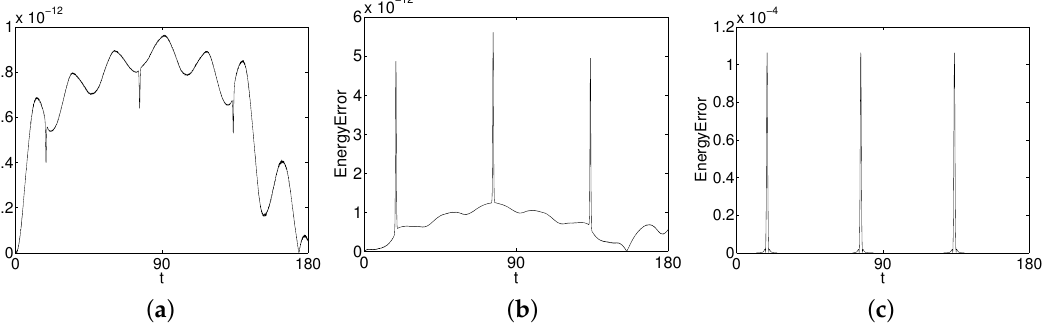
Figure 4. The kink and anti-kink solitary waves energy error of second order AVF method, fourth order composition method and second order Preissman method in t ∈ [ 0,200 ] with τ = 0.02, h = 0.2. ( a ) AVF method; ( b ) composition method; and ( c ) Preissman